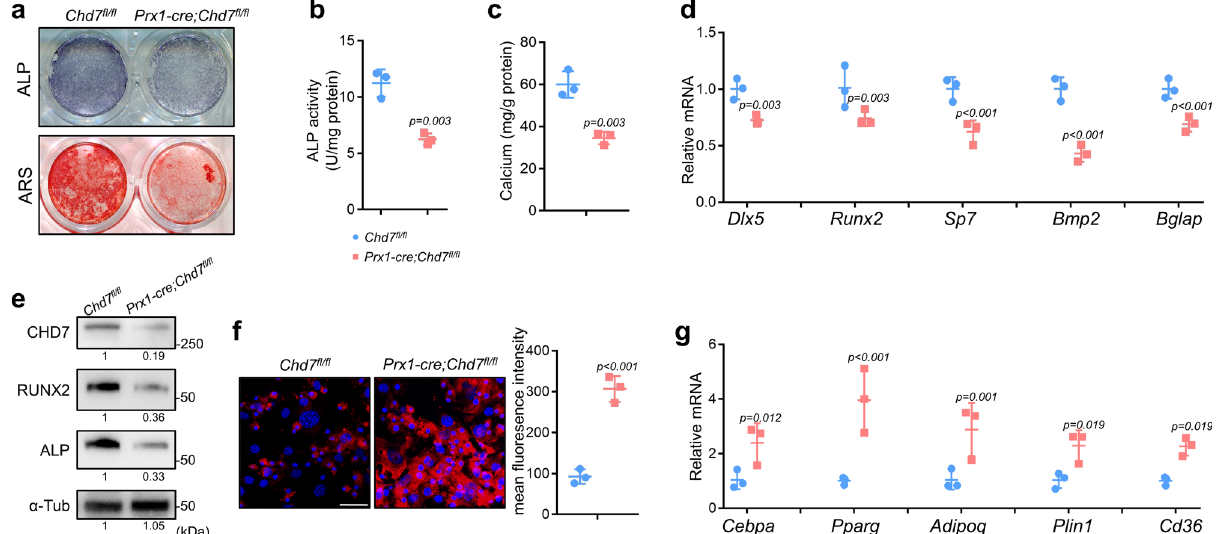
Fig. 4 Chd7 -de fi cient MSCs exhibit reduced osteogenic and increased adipogenic potential. a Representative images of ALP and ARS staining in MSCs. b Quantitative analyses of the ALP activity ( n = 3 biologically independent MSC sample). c Quantitative analyses of the mineralization ( n = 3 biologically independent MSC sample). d qRT-PCR analyses of the mRNA expression of Dlx5, Runx2, Sp7, Bmp2 , and Bglap in MSCs under osteogenic conditions ( n = 3 biologically independent MSC sample) e Western blot analysis and quanti fi cation of CHD7, RUNX2 and alkaline phosphatase in bone marrow MSCs isolated from the Chd7 fl / fl and Prx1-cre;Chd7 fl / fl mice. f Representative images and quantitative analyses of Nile red staining in MSCs. Scale bar, 50 μ m ( n = 3 biologically independent MSC slides). g qRT-PCR analyses of the mRNA expression of Cebpa, Pparg, Adipoq, Plin1, CD36 in MSCs under adipogenic conditions ( n = 3 biologically independent MSC samples). Data are shown as the mean ± S.D.; p value by two-tailed Student ’ s t